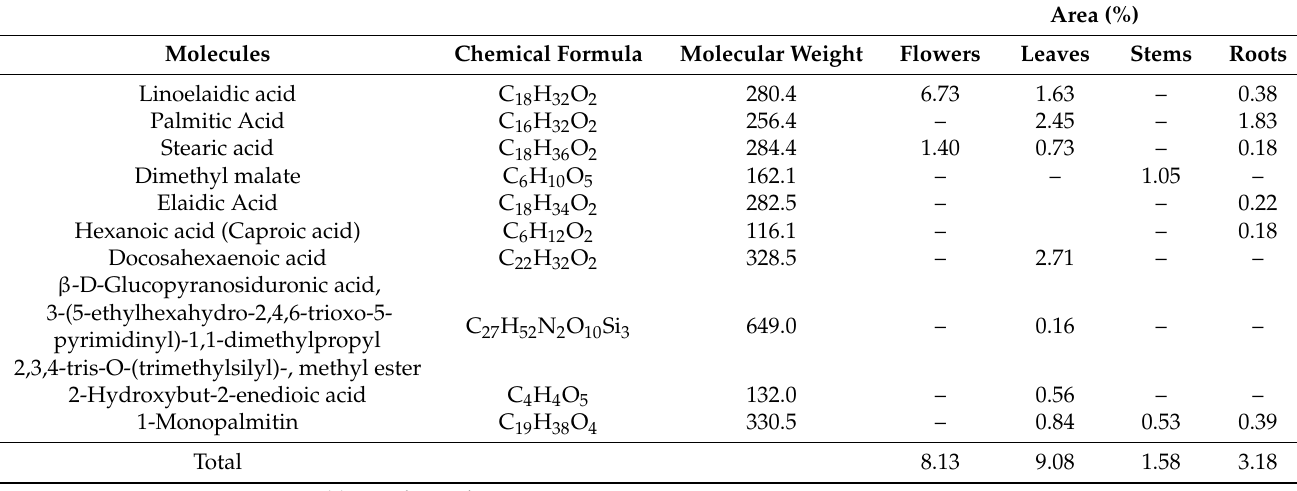
Table 6. Fatty acids of derivatized methanolic extracts obtained by GC-MS.